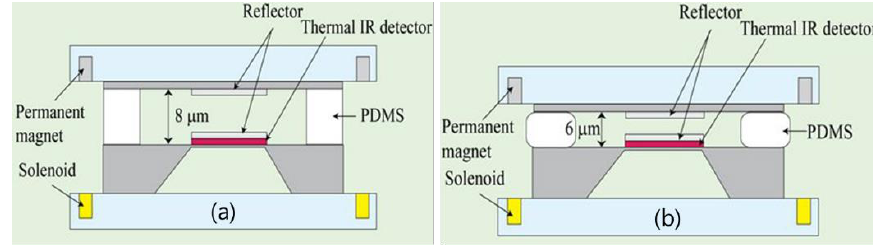
Figure 6. ( a ) Current-temperature characteristics of the micro heater and ( b ) temperature-resistance characteristics of the micro temperature sensor.